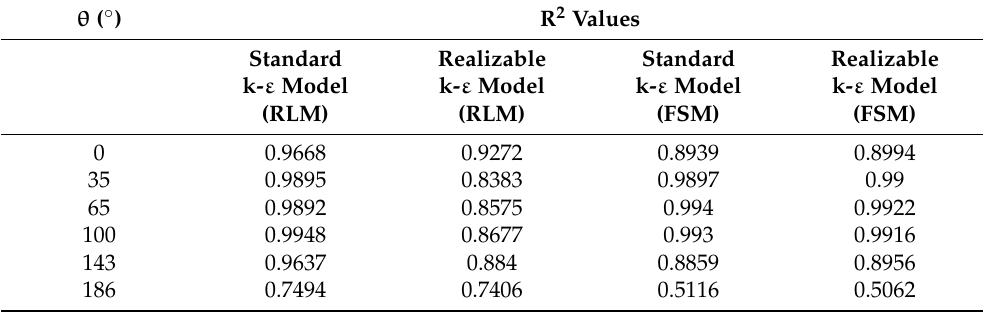
Table 3. R 2 values of resultant velocities shown in Figure 9.